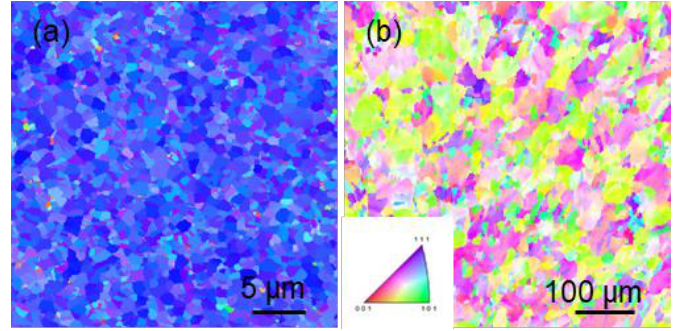
Figure 7. The grain orientation image maps of ( a ) <111>-oriented nt-Cu, and ( b ) <110>-oriented mt-Cu after annealing at 250 °C for 180 min.